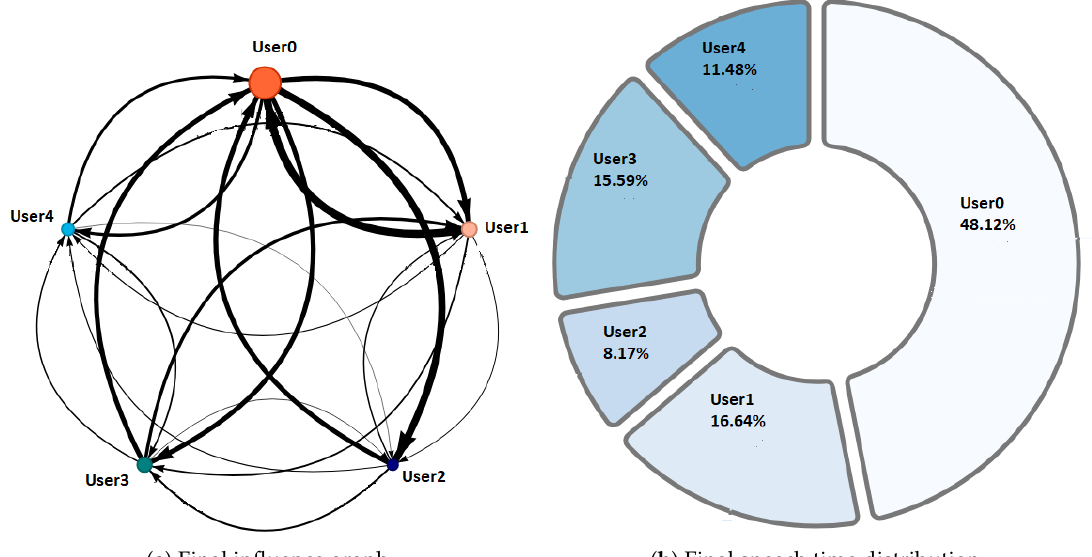
Figure 13. Final Behavior observed in